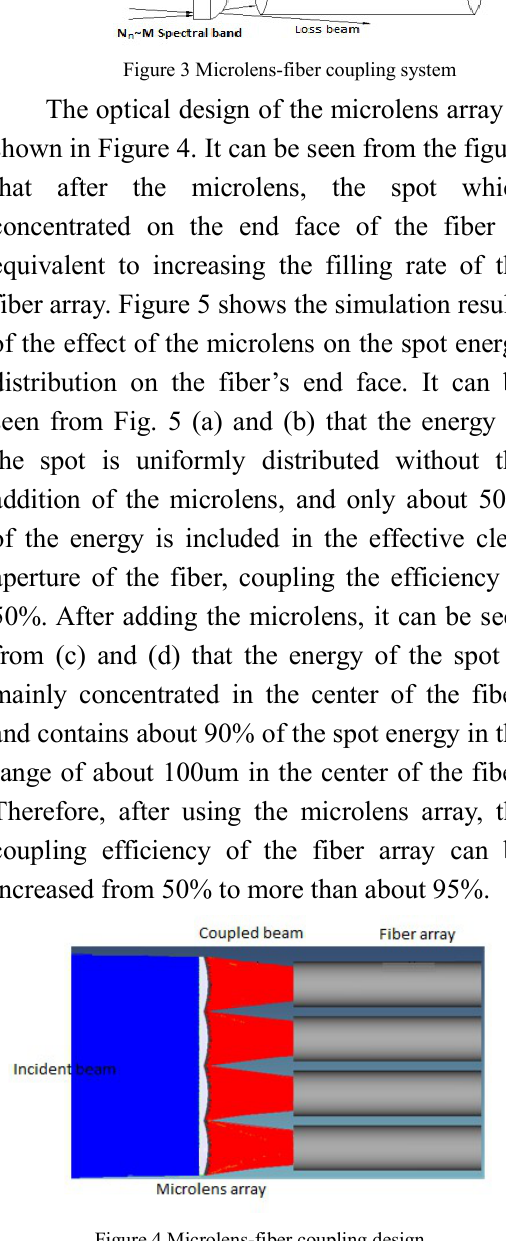
Figure 4 Microlens-fiber coupling